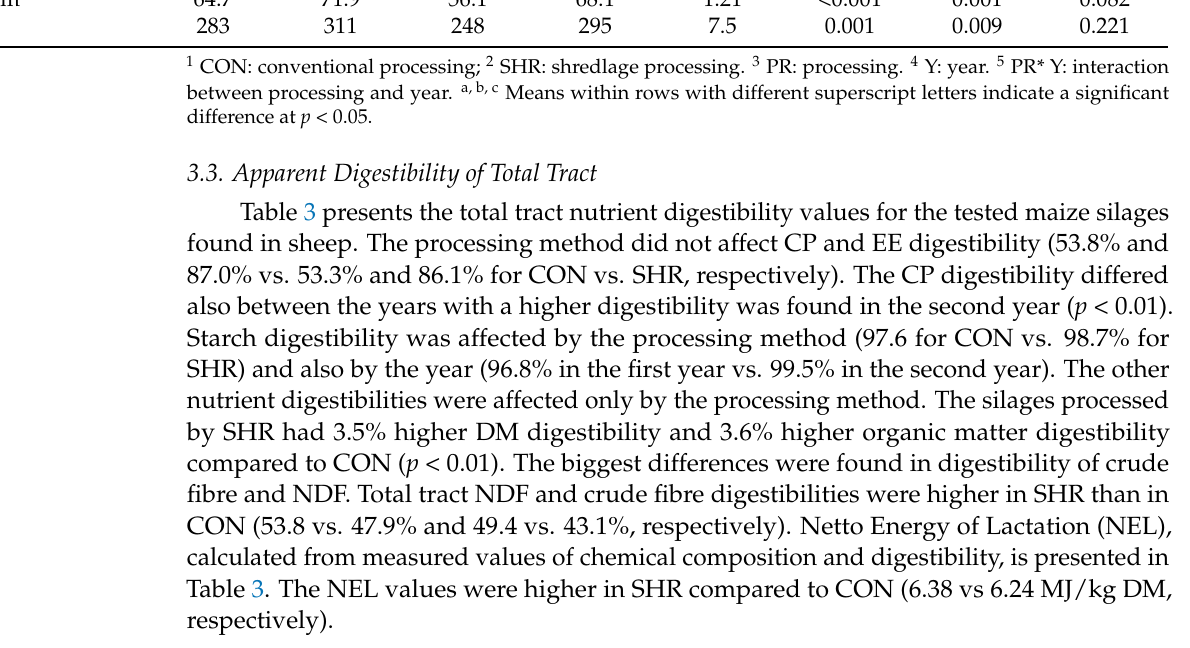
Table 3. Effect of maize silage processing on in vivo digestibility of